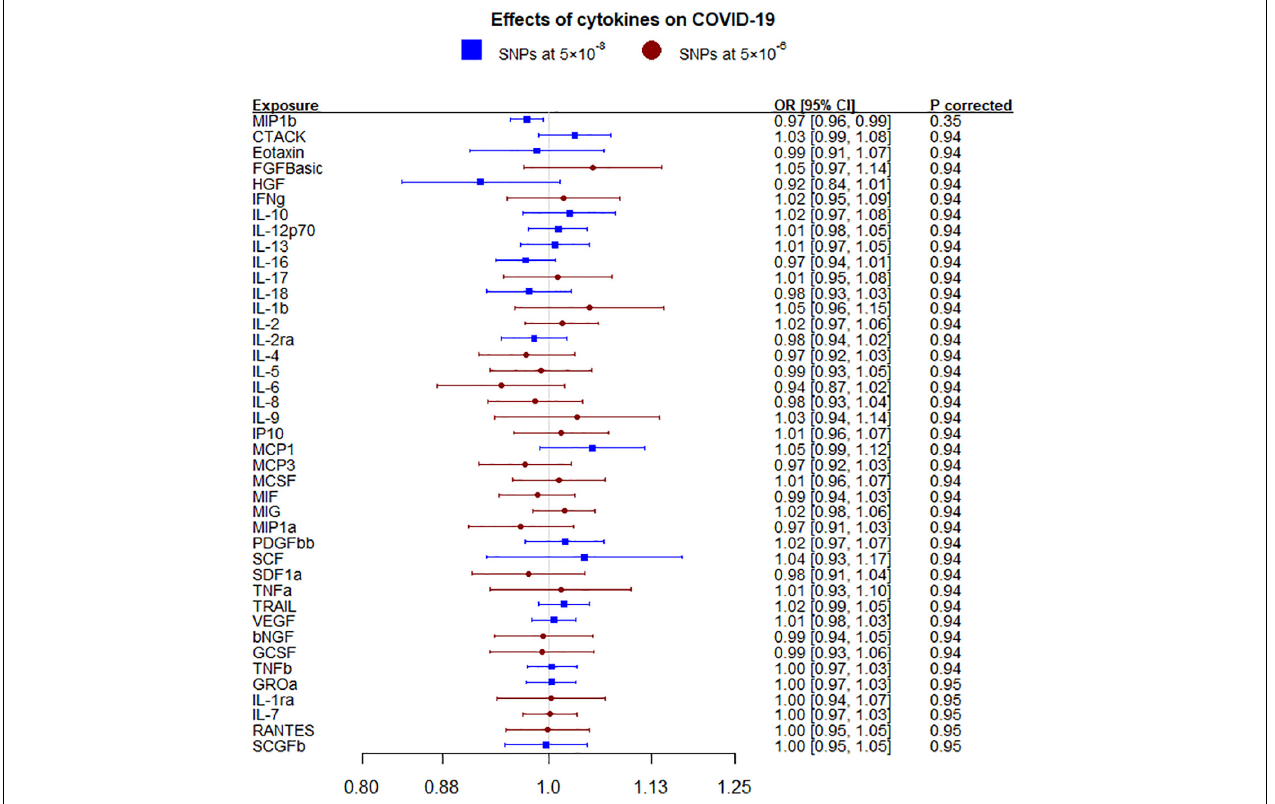
FIGURE 1 | Effects of 41 circulating cytokines on COVID-19 using inverse variance weighting with p -values using a Benjamini-Hochberg correction.